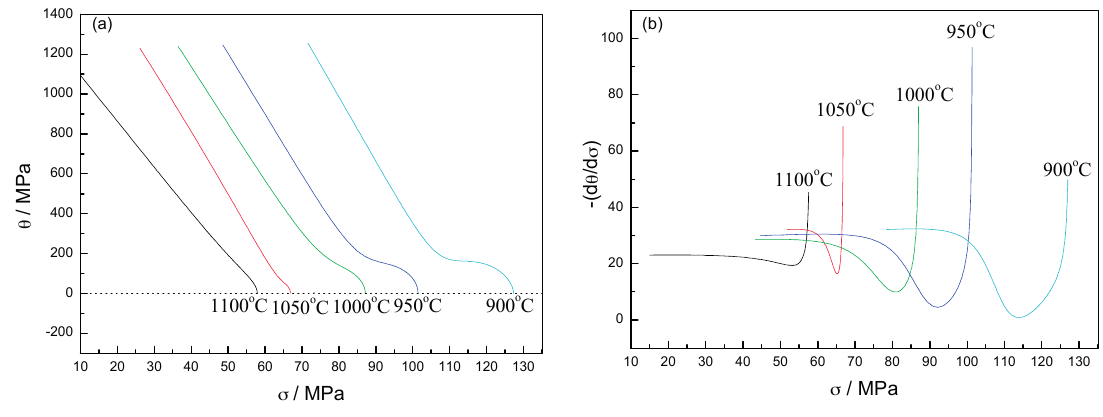
Figure 10. Strain harding rate ( θ ) versus true stress at 0.1 s − 1 for steel B2 at different temperatures. ( a ) θ - σ curves; ( b ) ( − (d θ /d σ ))- σ curves.